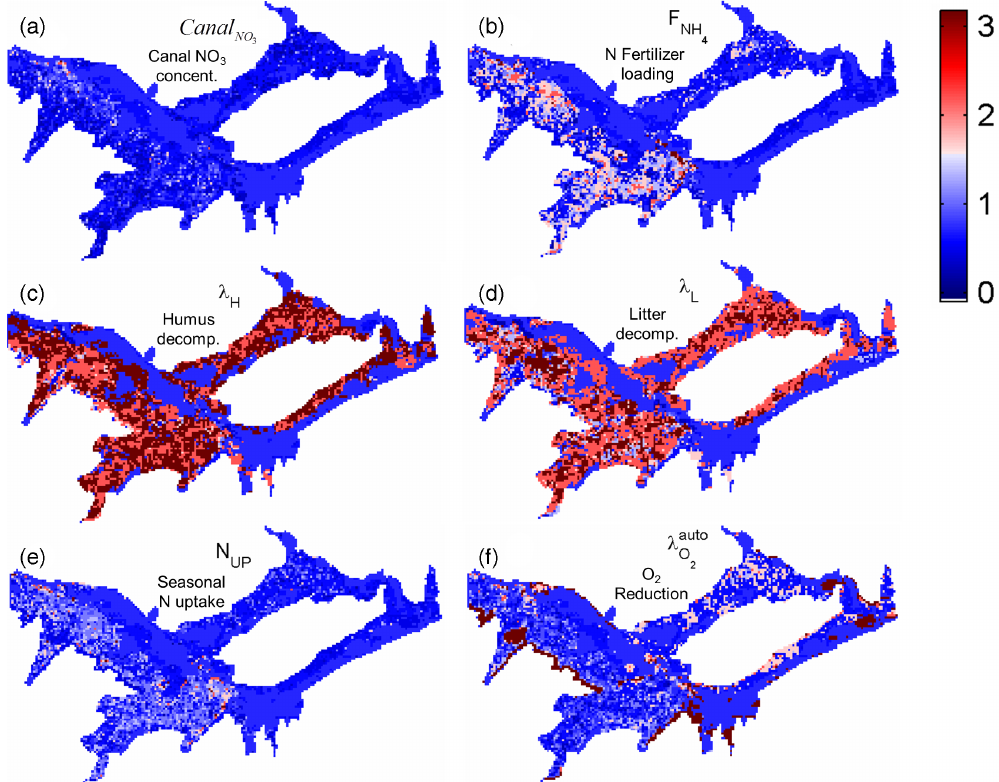
Figure 10. Cell-by-cell (250m by 250m) plots of Savage scores for (a) Canal NO the ranking of influence of that parameter on C O